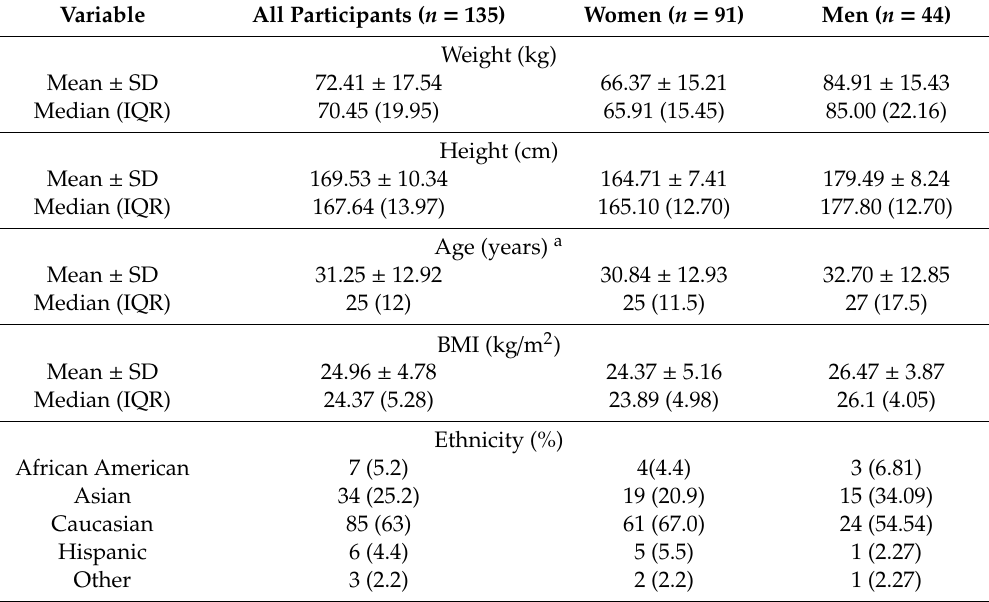
Table 1. Demographic characteristics of study participants.